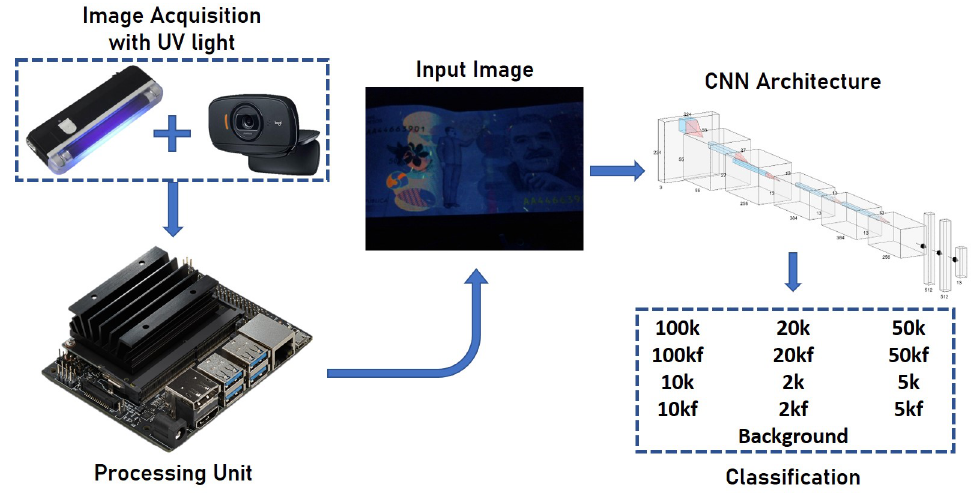
Figure 5. Proposed capture module for the detection of denominations and counterfeit banknotes using a CNN.